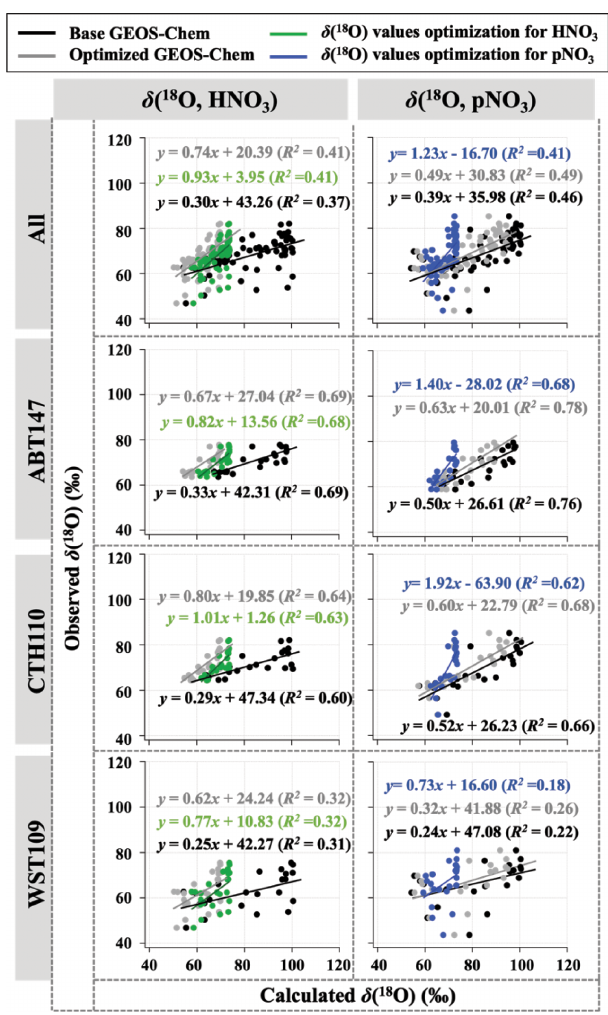
Figure 9. Correlation between observed and calculated δ ( 18 O) for HNO 3 and pNO 3 by each site. Calculated δ ( 18 O) values using base GEOS-Chem, optimized GEOS-Chem, and optimized δ ( 18 O) val- ues indicated as black, gray, and green (for HNO 3 ) or blue (for pNO 3 ),